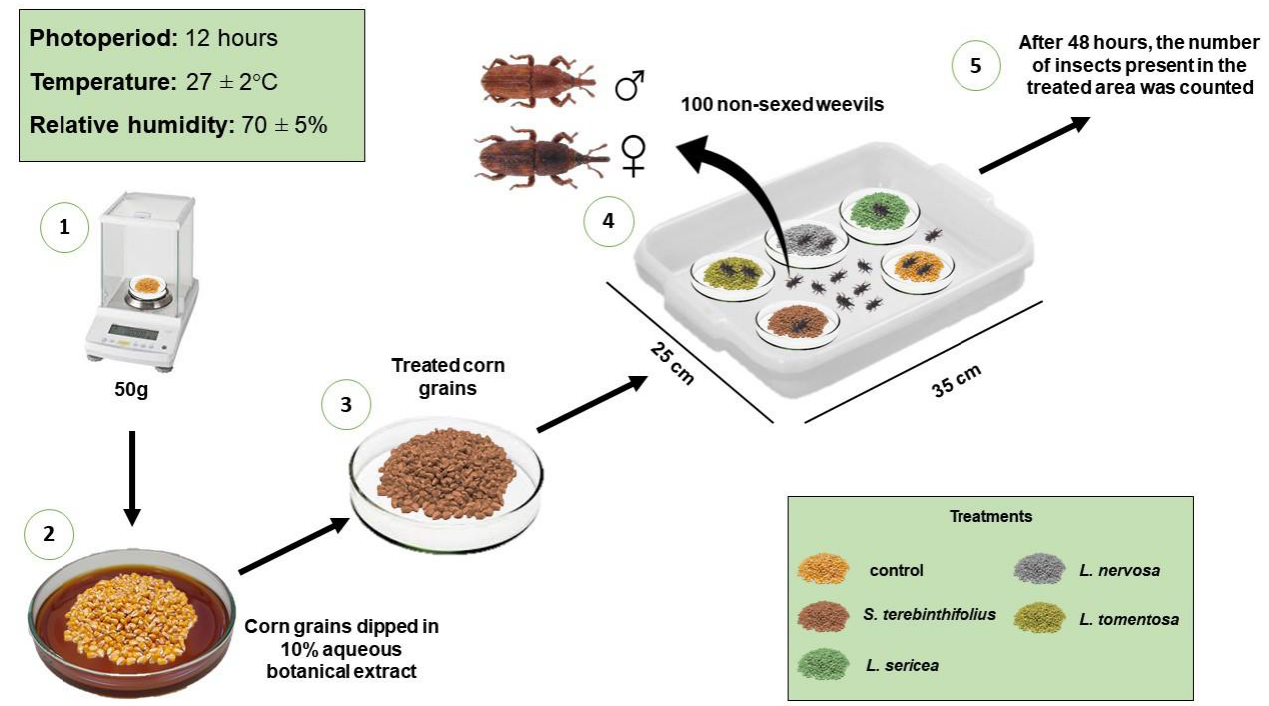
Figure 1. The schematic representation of methodology of the test to evaluate the repellency of botanical extracts to Sitophilus zeamais .